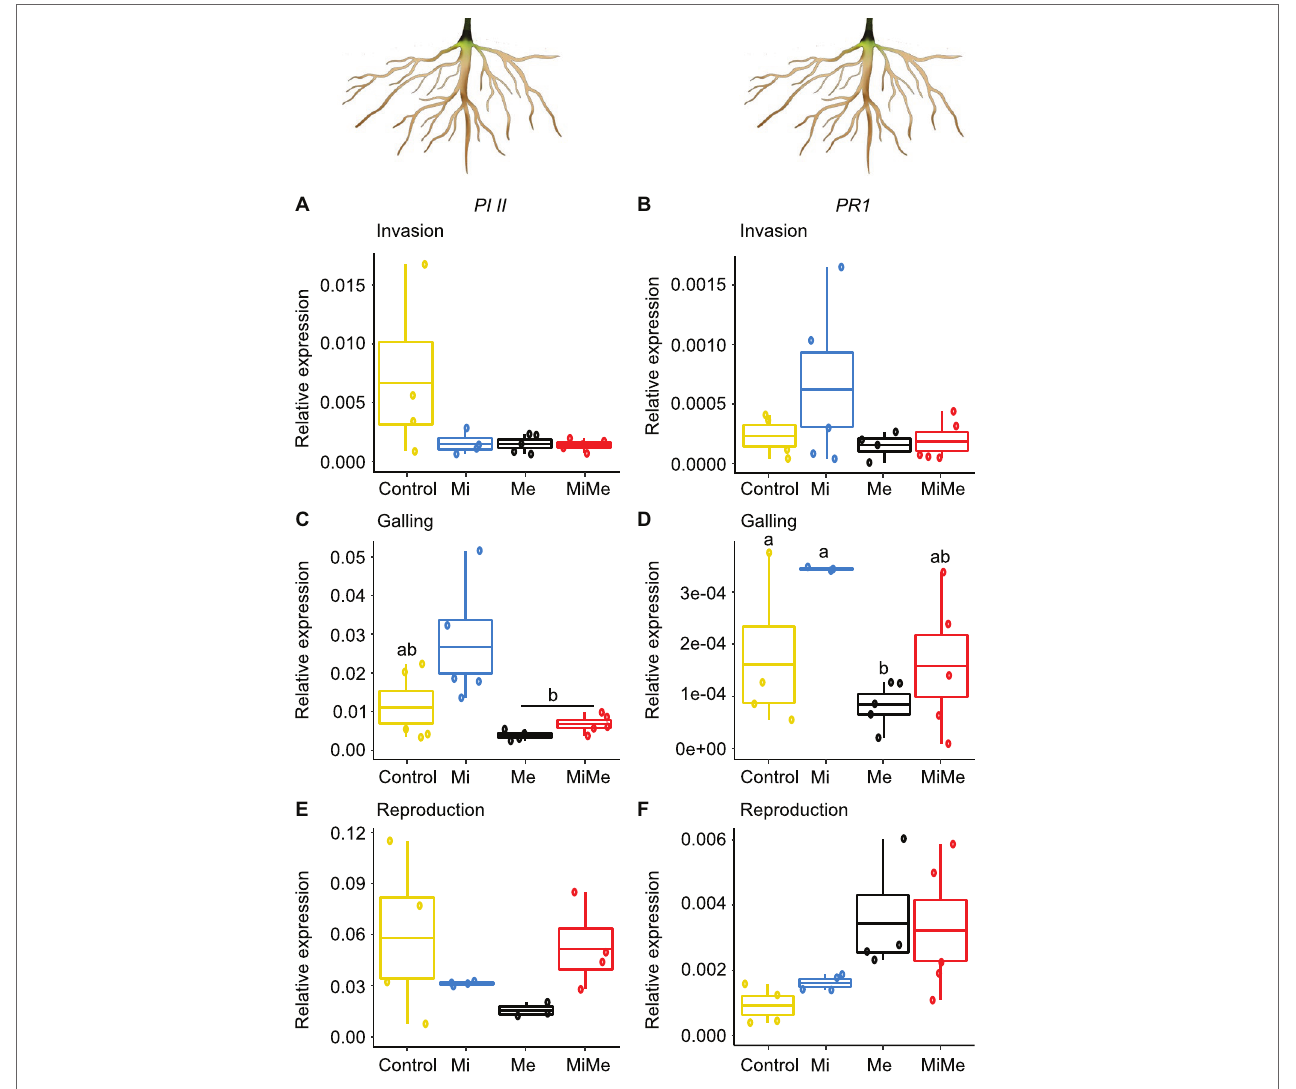
FIGURE 5 | Expression of the jasmonic acid (JA) marker gene Proteinase inhibitor II (PI II) and the salicylic acid (SA) marker gene Pathogenesis-related protein 1 (PR1) in tomato roots upon aboveground and belowground herbivory. Relative expression of PI II and PR1 genes were analyzed in roots of tomato plants infected belowground with Meloidogyne incognita (Mi), infested aboveground with Macrosiphum euphorbiae (Me), or with both herbivores (MiMe). Control = plants without herbivores. Boxplots indicate mean (±SEM, n = 5) expression values of PI II (A,C,E) and PR1 (B,D,F) measured at the nematodes’ invasion (A,B) , galling (C,D) , or reproduction (E,F) stages. Different letters above the boxplots indicate significant differences ( p ≤ 0.05) in mean expression among treatments, determined by Tukey's HSD test after ANOVA